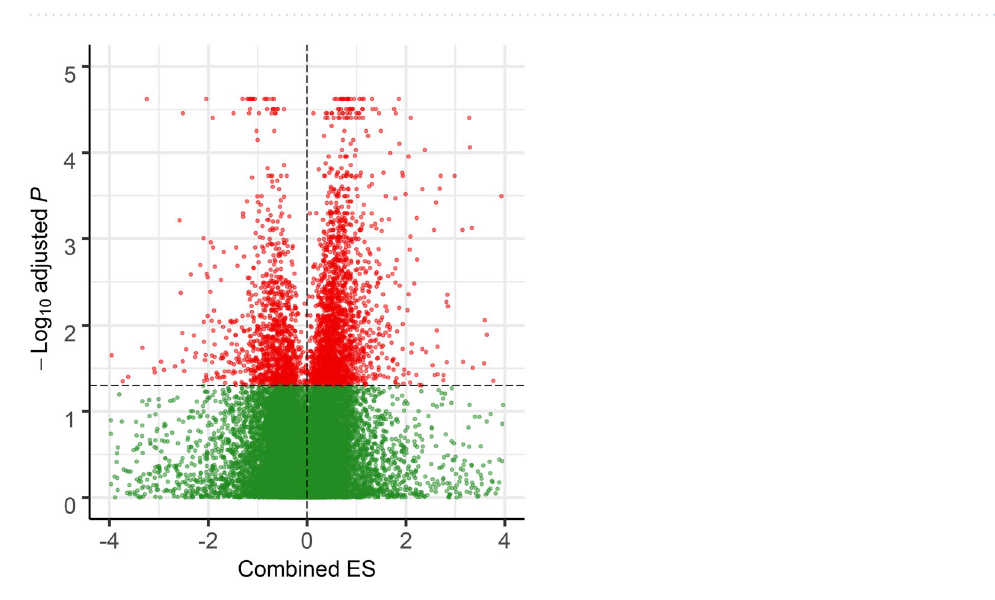
Figure 1. A schematic overview of the multistep strategy for understanding aspects of the response of Populus to drought stress.